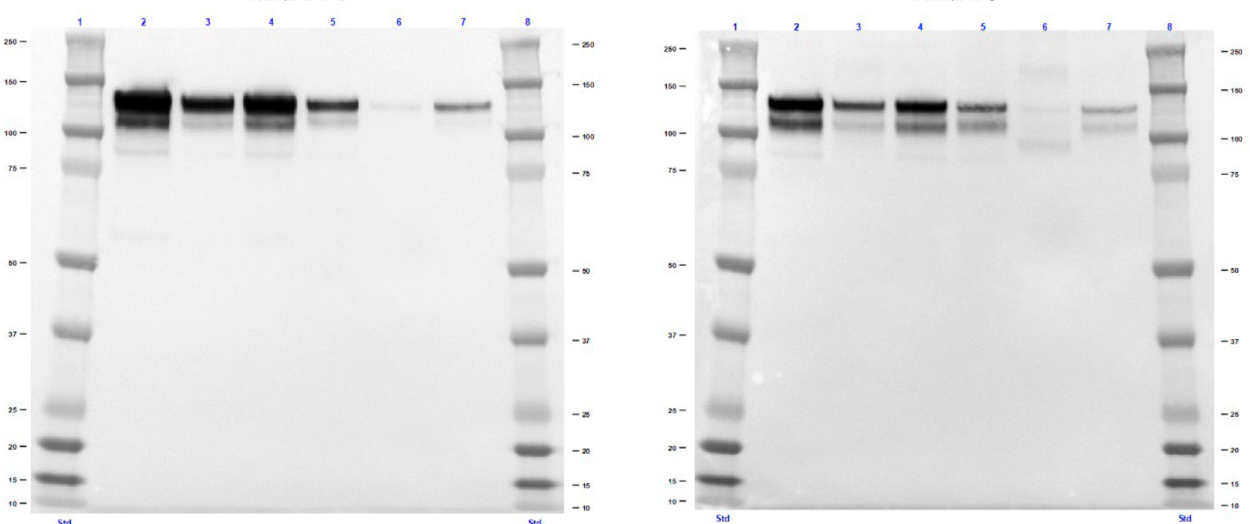
Figure A3. Uncropped western blot images shown in Figure 4a (secreted proteins).